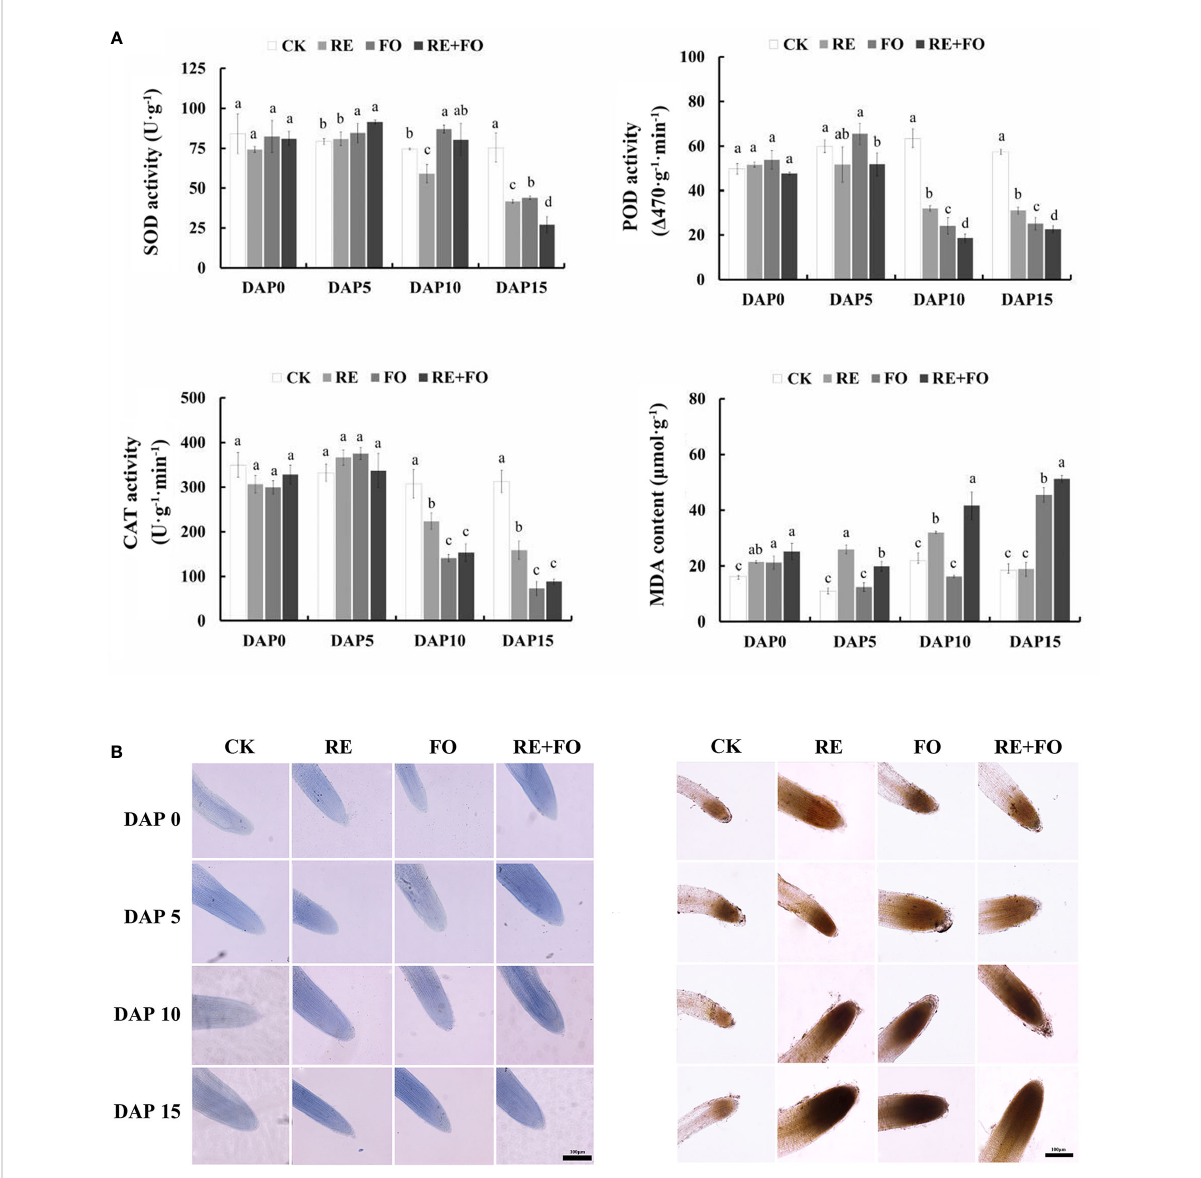
FIGURE 2 Changes in physiological indexes (A) and reactive oxygen species (ROS) levels (B) of Rehmannia glutinosa seedlings under root exudates, F . oxysporum and comprehensive stress of root exudates and F . oxysporum . (A) : Measurement of SOD, POD, CAT and detection of MDA in R. glutinosa roots under root exudates, F . oxysporum and comprehensive stress of root exudates and F . oxysporum ; (B) : ROS levels of Rehmannia glutinosa root tip stained with Trypan blue (left) and DAB (right) mediated by the treatments of root exudates, F . oxysporum and comprehensive stress of root exudates and F . oxysporum . Bar = 100 m m. DAP, Days after planting; RE, the treatment of root exudates; FO, the treatment of F.oxysporum; RE+FO, the comprehensive treatment of root exudates and F. oxysporum. Different letters represent a signi fi cant difference at p <